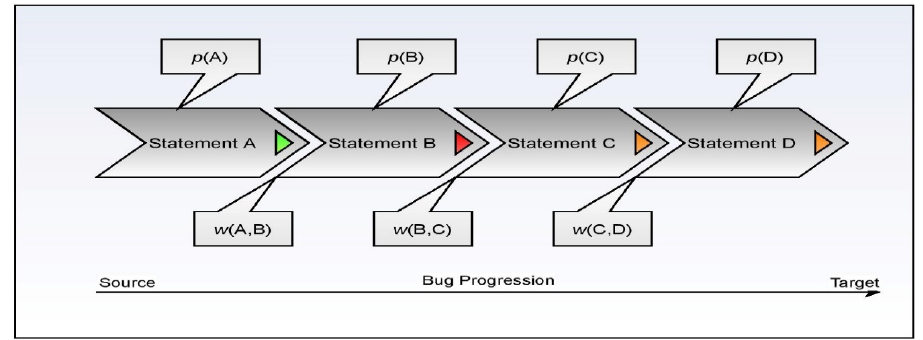
Figure 4. Represents the aggregative score model for fault localization.